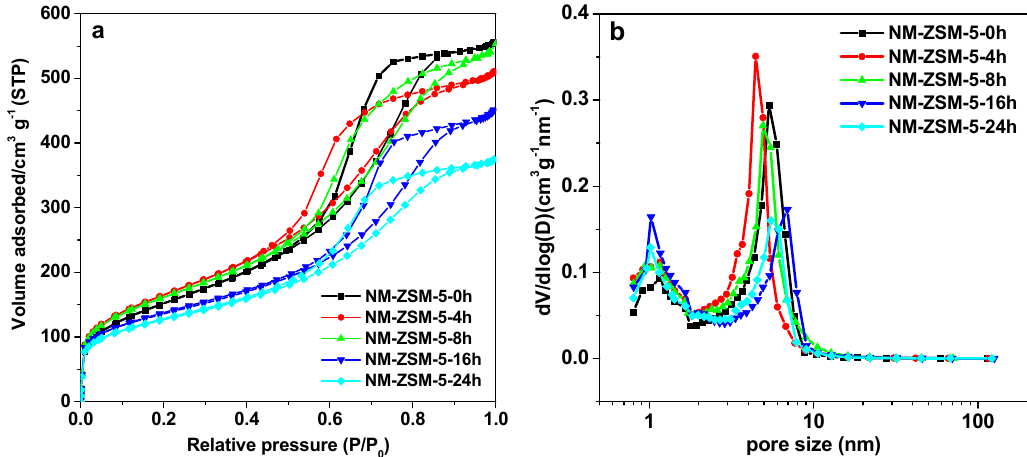
Figure 3. ( a ) N 2 adsorption-desorption isotherms and ( b ) pore distribution of the samples.